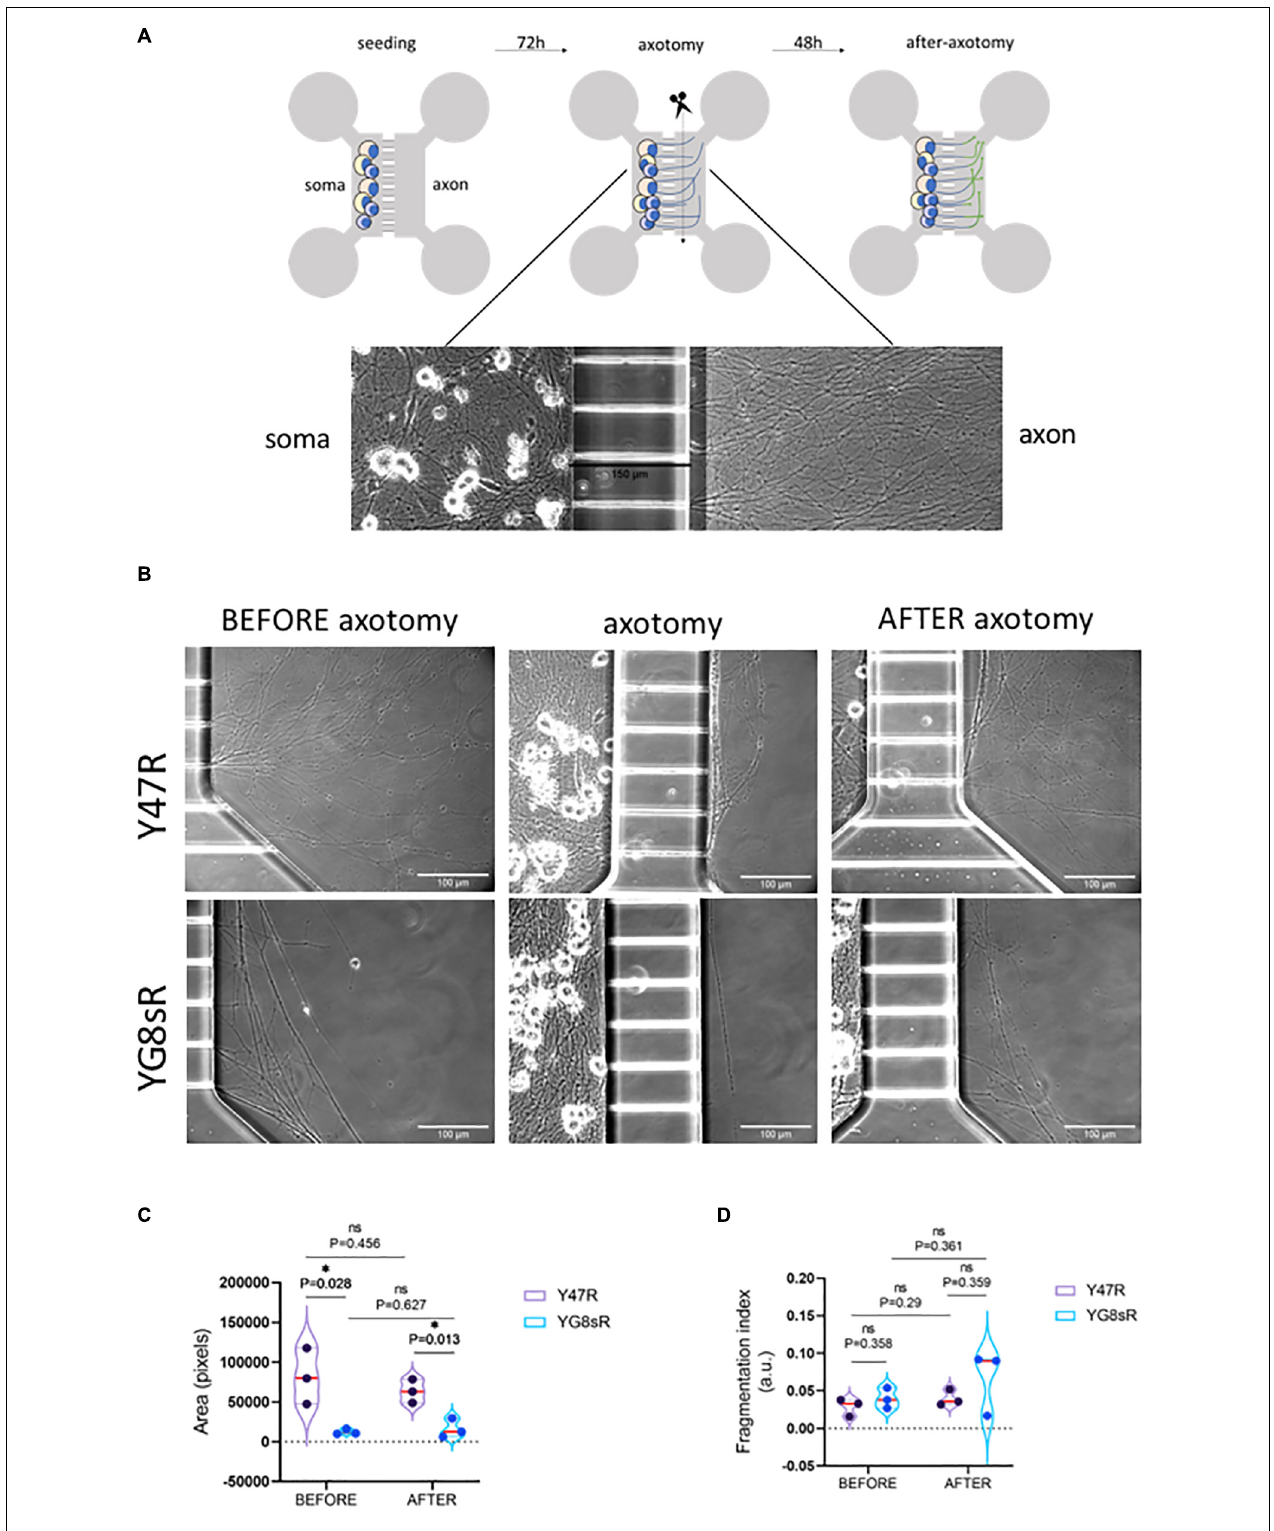
FIGURE 5 | Adult DRG neurons from the YG8sR mouse reduce their natural regenerative response after an injury in vitro. (A) Scheme of a microfluidic device (upper panel) and steps of the experiment (bottom panel). Each device has two identical compartments connected with microfluidic channels (150 µ m in length). Neuronal somas were seeded into one of the chambers (soma-chamber), and were allowed to grow under a neurotrophic gradient pushing them to grow their axons crossing the microchannels. Axotomy (or cutting of axons) was performed 3 days in culture, and neurons were cultured for 2 days more. Images show a typical view of